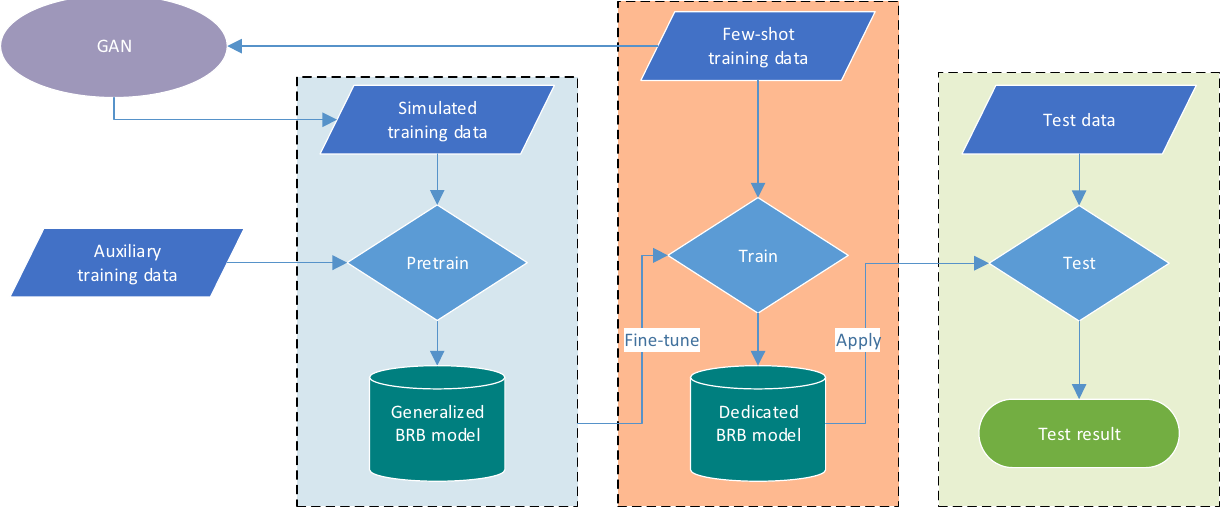
Fig. 2 The GT-BRB implementation